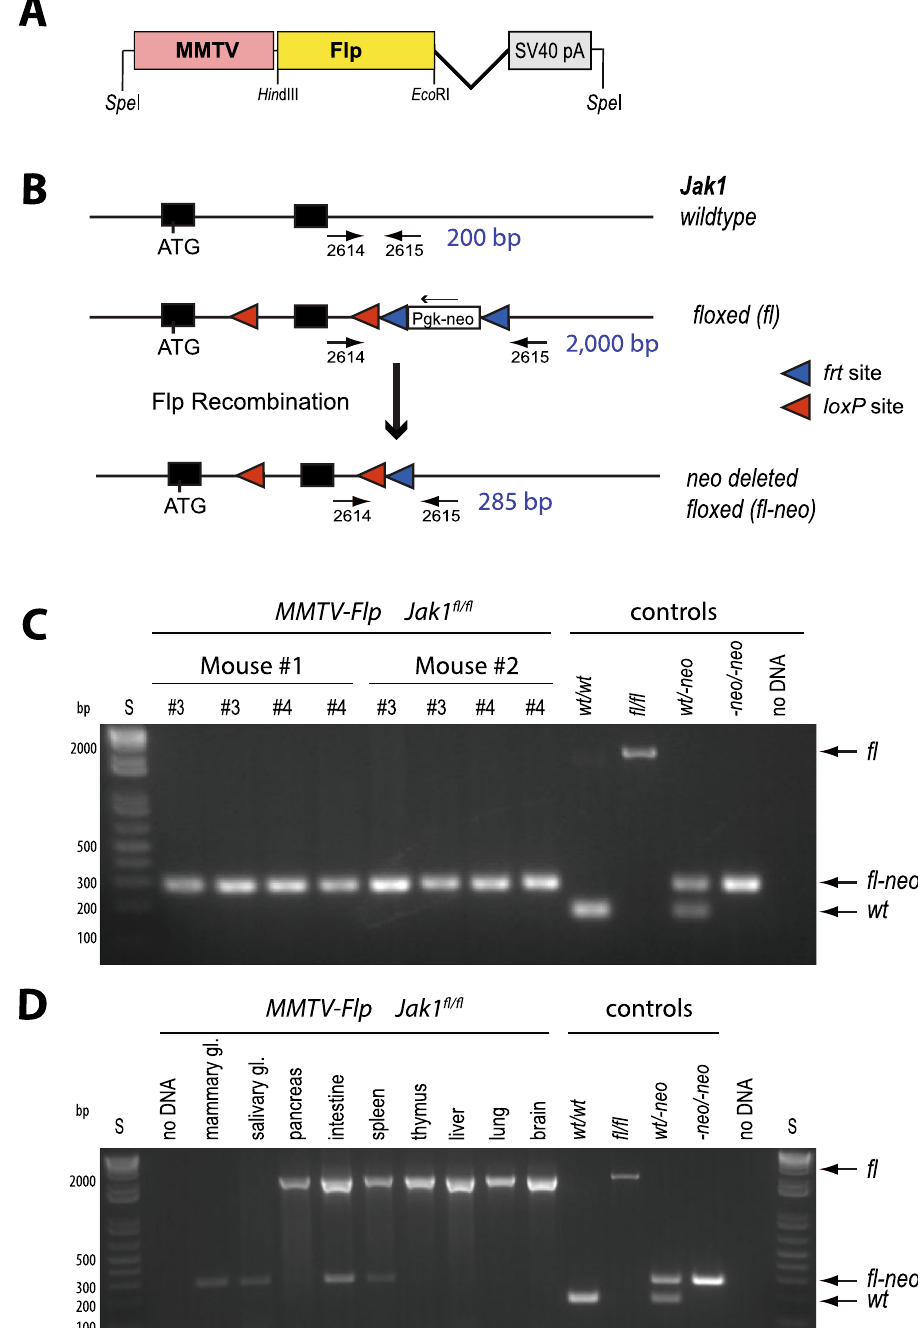
Figure 1. Generation of a transgenic mouse line expressing the Flp recombinase in the mammary gland. ( A ) Schematic outline of the MMTV-Flp transgene. ( B ) Diagram of the Jak1 conditional knockout allele and its use as a reporter for the Flp-mediated excision of the neomycin (neo) selection cassette that is flanked by recognition sites ( frt ) for the recombinase. Arrows indicate the location of PCR primers to assess the Flp- mediated recombination. ( C ) PCR-based validation of the Flp-mediated recombination in the thoracic (#3) and inguinal (#4) mammary glands of two lactating MMTV-Flp Jak1 fl/fl females. DNA from mouse embryonic fibroblasts with defined genetic alterations in the conditional Jak1 allele were used as controls. ( D ) PCR assay to detect Flp recombinase activity in selective organs. MMTV mouse mammary tumor virus long terminal repeat, SV40 pA intron and polyadenylation sequence (pA) of the simian polyomavirus 40, frt Flp recognition target site, loxP Cre recombinase target site, Pgk-neo neomycin selection marker driven by the phosphoglycerate kinase 1 (Pgk) promoter, ATG start codon, S DNA standard ladder, Jak1 allele designation, wt wildtype, fl conditional knockout, flanked by lox P sites, fl-neo fl allele with a Flp recombinase-mediated deletion of the neomycin selection